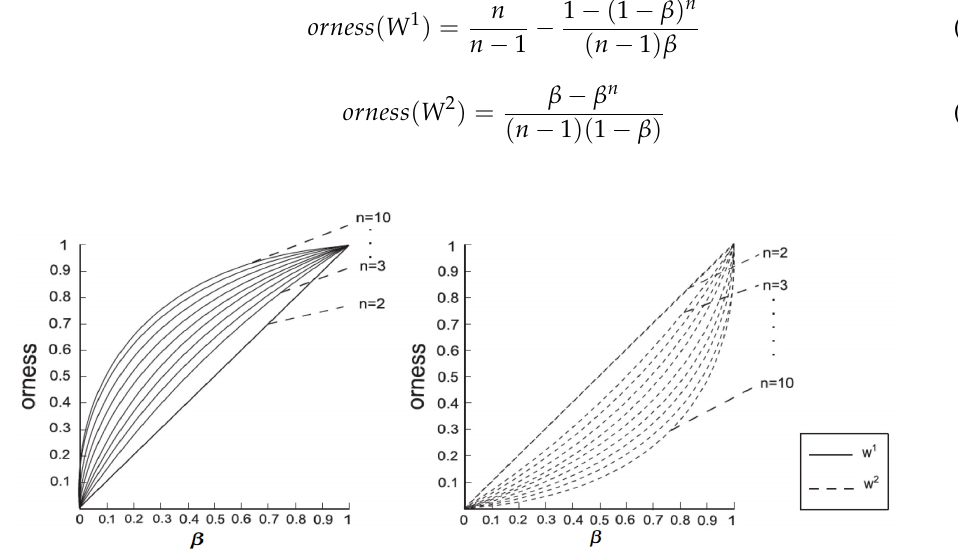
Figure 3. Functional relationship between the orness measure and parameter β of W 1 and W 2 (adapted from